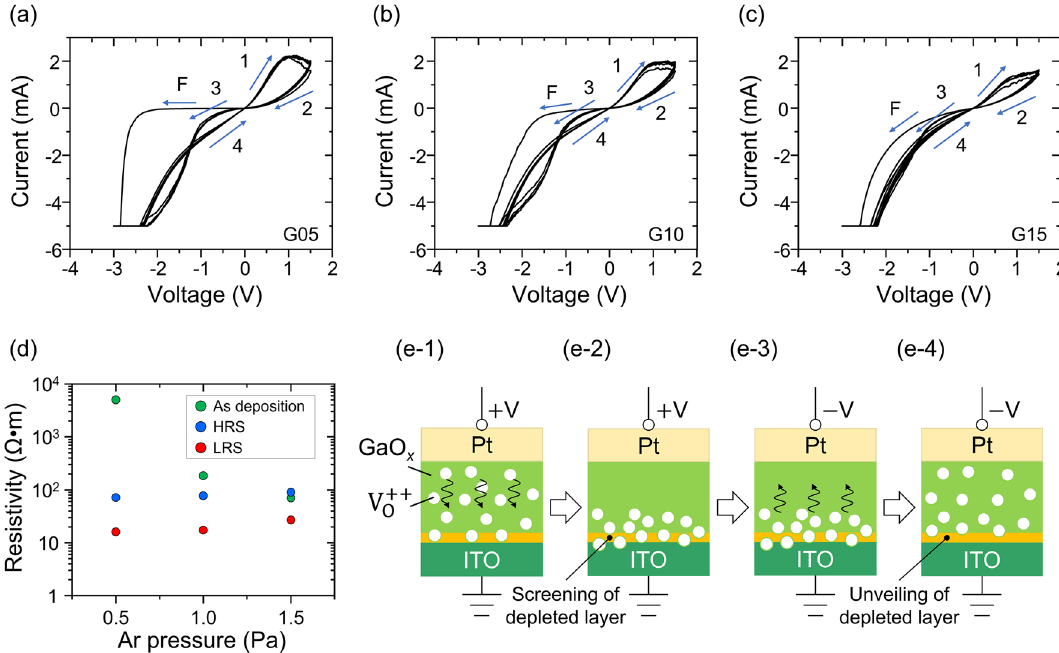
Figure 2. I–V curves obtained at room temperature for Samples ( a ) G05, ( b ) G10, and ( c ) G15. ( d ) Measured resistivity of the GaO x films before switching the resistance at the HRS and the LRS depending on P Ar during PLD. ( e ) Schematics of oxygen vacancy distribution in the memristor corresponding to the situation of the voltage sweep through Regions